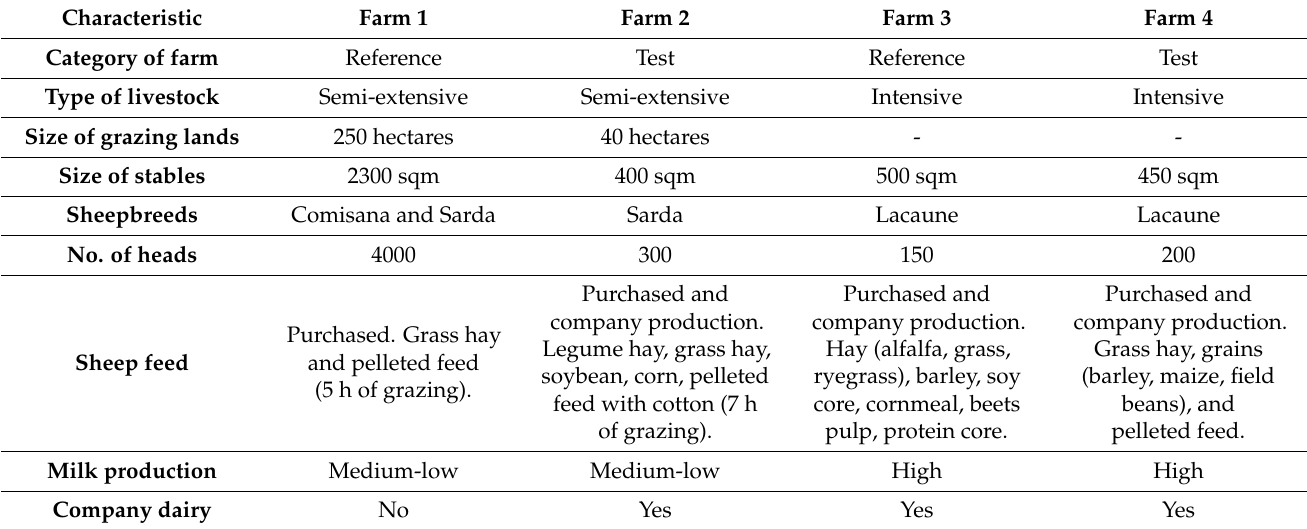
Figure 1. Geospatial map of Latium region (latitude N from 41°26′ to 41°58′ and longitude E from 12°24′ to 13°34′). The map shows the area contaminated by β-HCH (light brown borders) divided into three regions according to different levels of contamination as reported previously [7]: low contamination (yellow), intermediate contamination (orange), and high contamination (red). The map also shows the position of the four farms enrolled in the study (black circles). Table 1. Main characteristics of the examined farms.